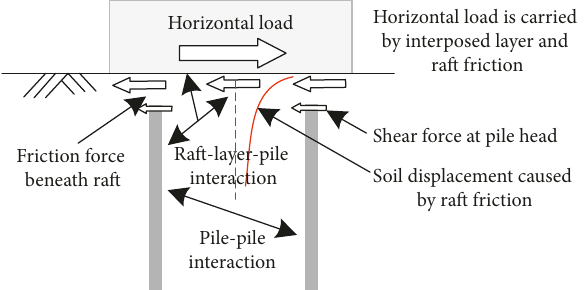
Figure 1: Horizontal load distribution within the disconnected piled raft foundations under a horizontal